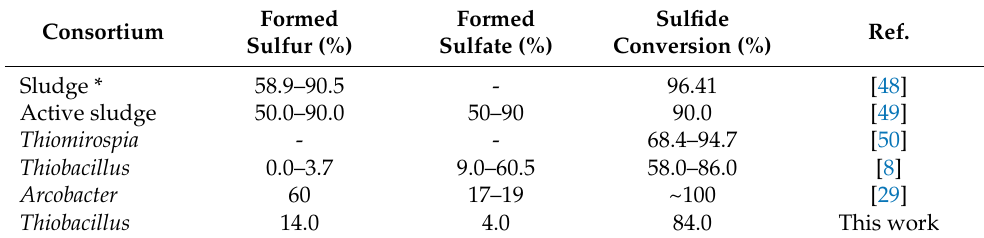
Table 5. Sulfur removal study performance from several studies.